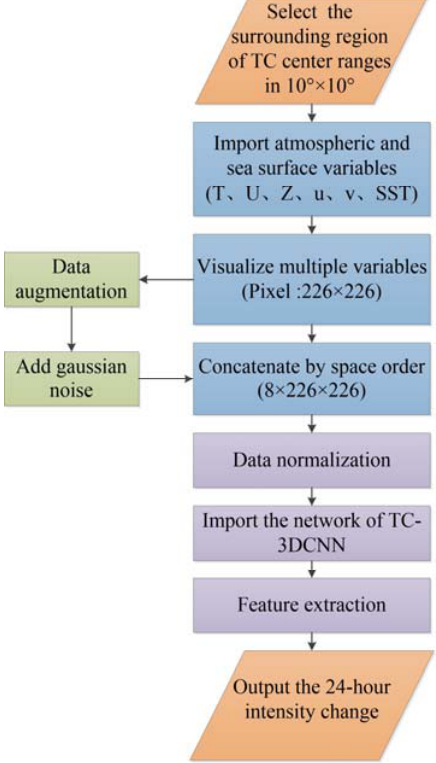
Figure 2. Flow chart of tropical cyclone (TC) intensity change prediction.